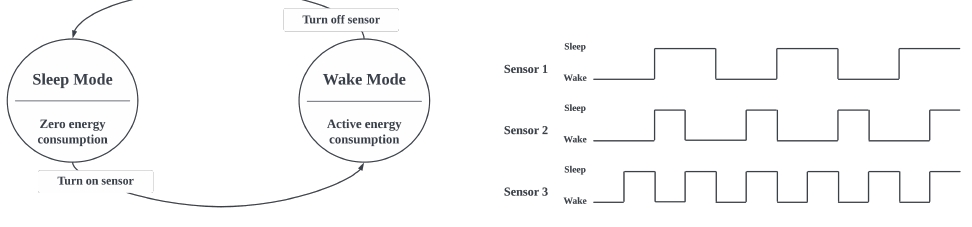
Figure 3. Sensors attached to a device are managed by sleep-and-wake cycles; ( a ) Sensor state diagram showing the endless sleep-and-wake cycle observed by each sensor independent of other sensors on the same device; ( b ) Sensor timing diagram showing three sensors on the same device maintaining sleep-and-wake cycles independently.